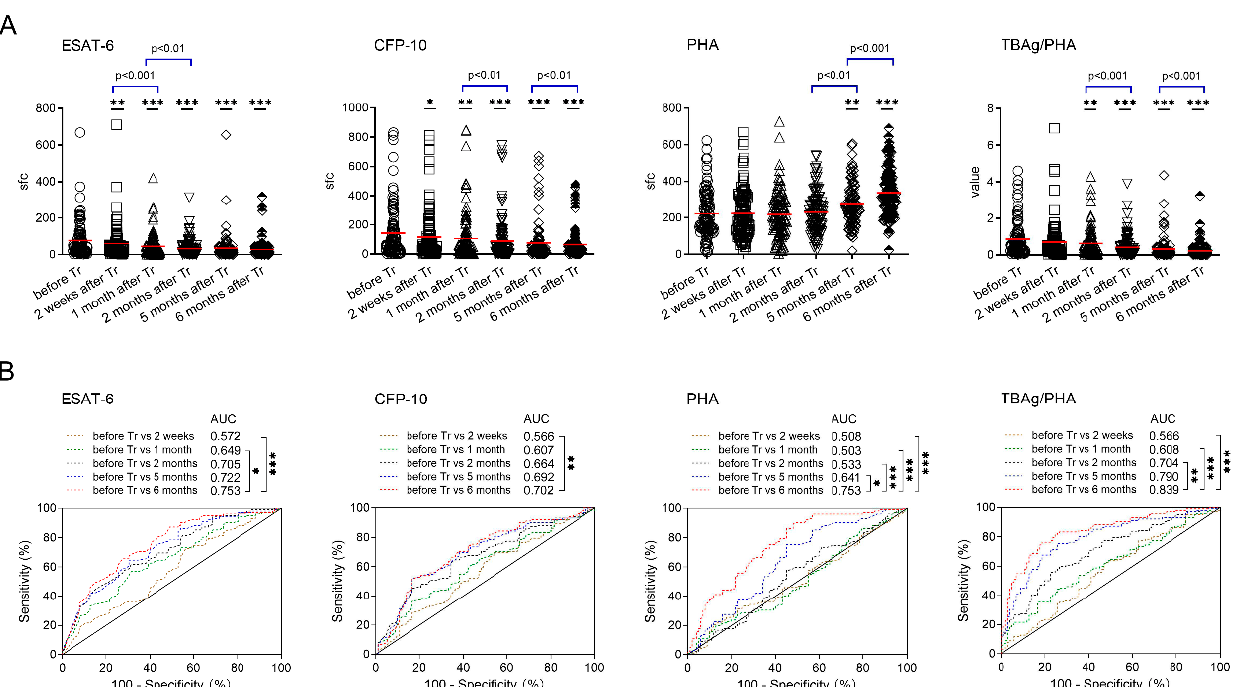
Figure 2. T-SPOT results in patients with successful treatment outcomes. ( A ) Dot plots showing ESAT-6 sfc, CFP-10 sfc, PHA sfc, and the TBAg/PHA ratio in patients before and after different time points (2 weeks, 1 month, 2 months, 5 months, 6 months) of TB treatment. Bars indicate means (* p < 0.05, ** p < 0.01, and *** p < 0.001, compared with before treatment). ( B ) Receiver operating characteristic analysis was performed for ESAT-6 sfc, CFP-10 sfc, PHA sfc, and the TBAg/PHA ratio to determine threshold values for distinguishing between before treatment and after different time points of treatment. * p < 0.05, ** p < 0.01, and *** p < 0.001. ESAT-6, early secreted antigenic target 6; CFP-10, culture filtrate protein 10; PHA, phytohemagglutinin; sfc, spot-forming cells. TBAg/PHA, the ratio of TB-specific antigen to phytohemagglutinin. Tr, treatment.